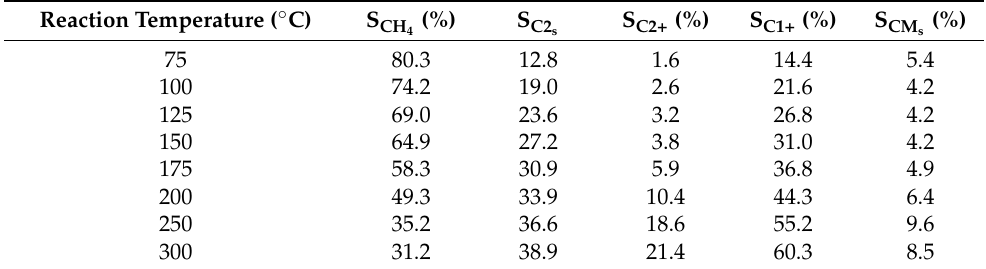
), C 2 hydrocarbons (S C2 ), hydrocarbons with more than two s 4 ) for IW-Pd. s